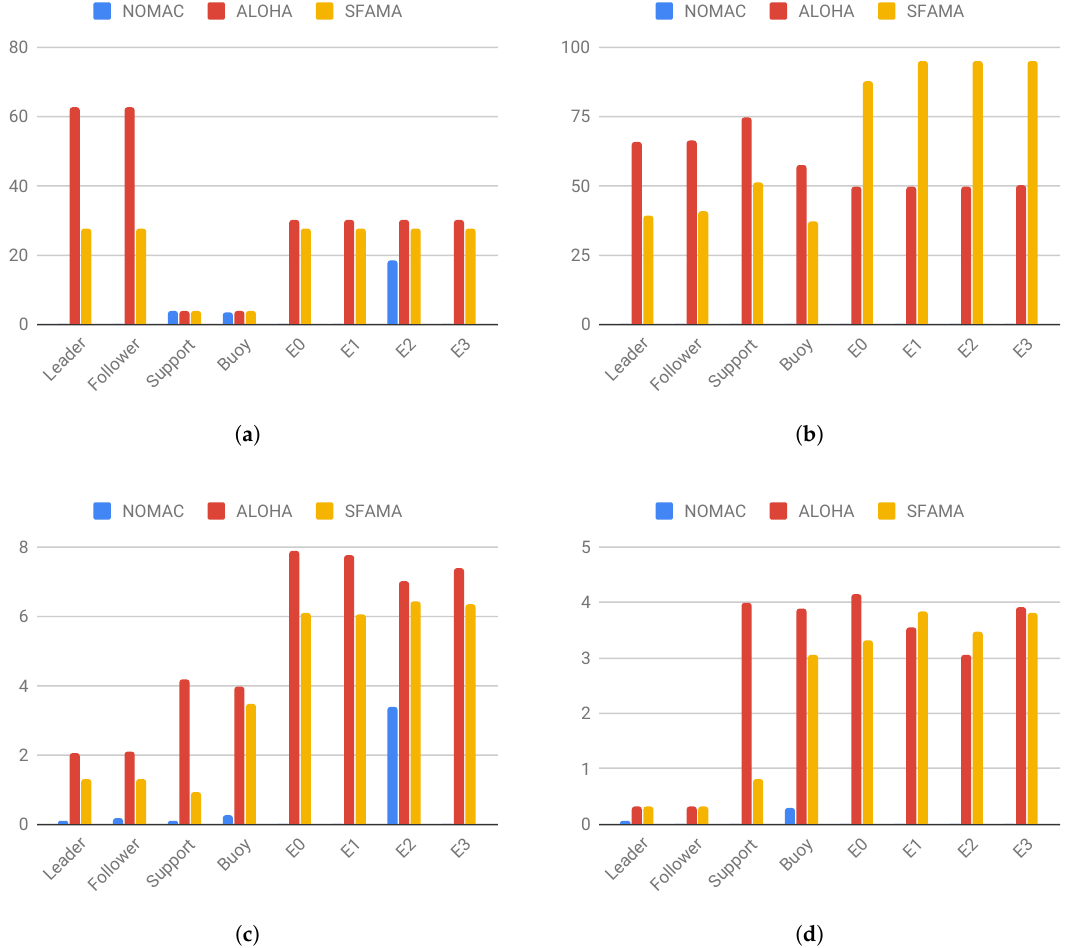
Figure 7. Results for the TWINBOT based scenario without considering any MAC protocol (NOMAC), considering CS-ALOHA MAC protocol (ALOHA) and the S-FAMA MAC protocol (SFAMA), in terms of: ( a ) throughput (bytes per second); ( b ) efficiency (%); ( c ) end-to-end delay (s); and ( d ) jitter